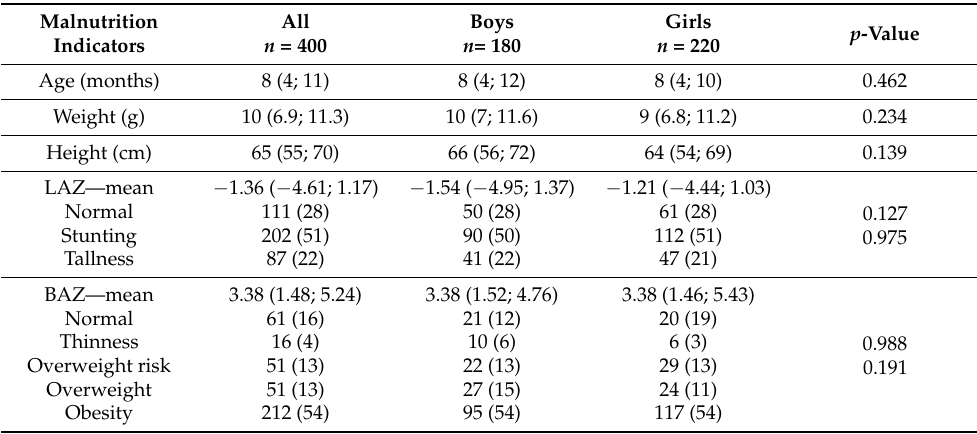
Table 3. Comparison of medians and prevalence of stunting and obesity among children by